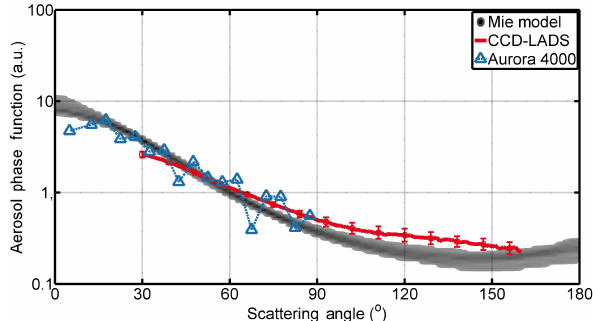
Figure 9. Comparison between aerosol phase function retrieved from CCD-LADS measurements (red line shows the average value, the error bar shows the standard deviation), measured from Aurora 4000 polar nephelometer (blue triangle) and modelled with modi- fied Mie model (grayscale